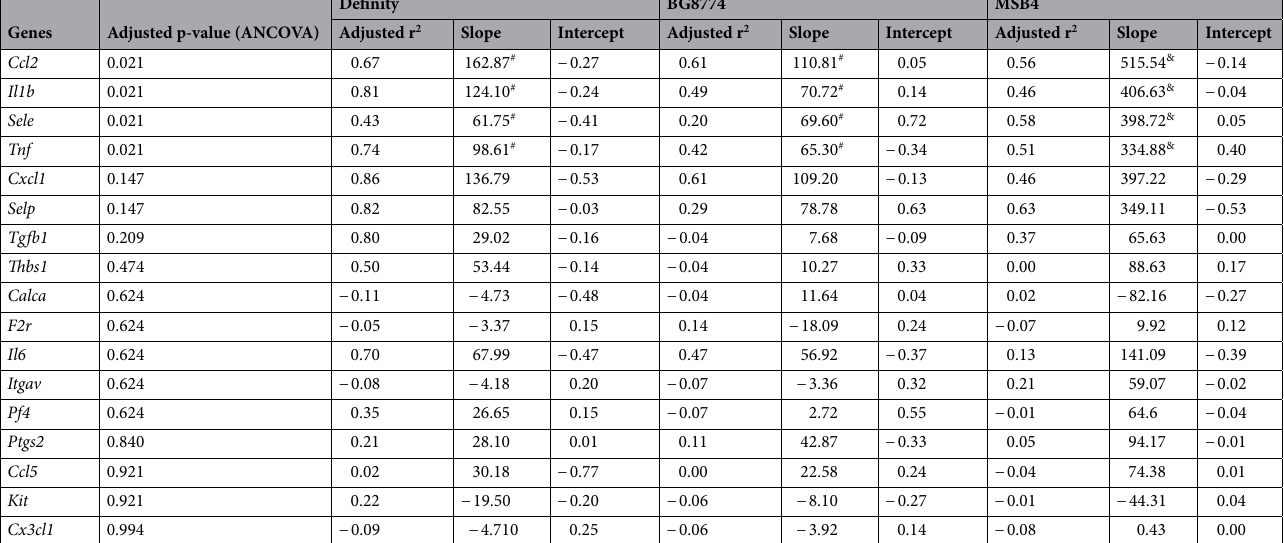
Table 5. Correlations between K trans and relative gene expression (GO term ‘Inflammatory Response’) for each microbubble formulation. Disparate symbols (# and &) indicate significantly different slopes (K trans vs relative gene expression) in pairwise post-hoc comparisons between microbubble formulations. Units of slope are log2 fold change in relative gene expression/min −1 (K trans of gadobutrol). ANCOVA analysis of